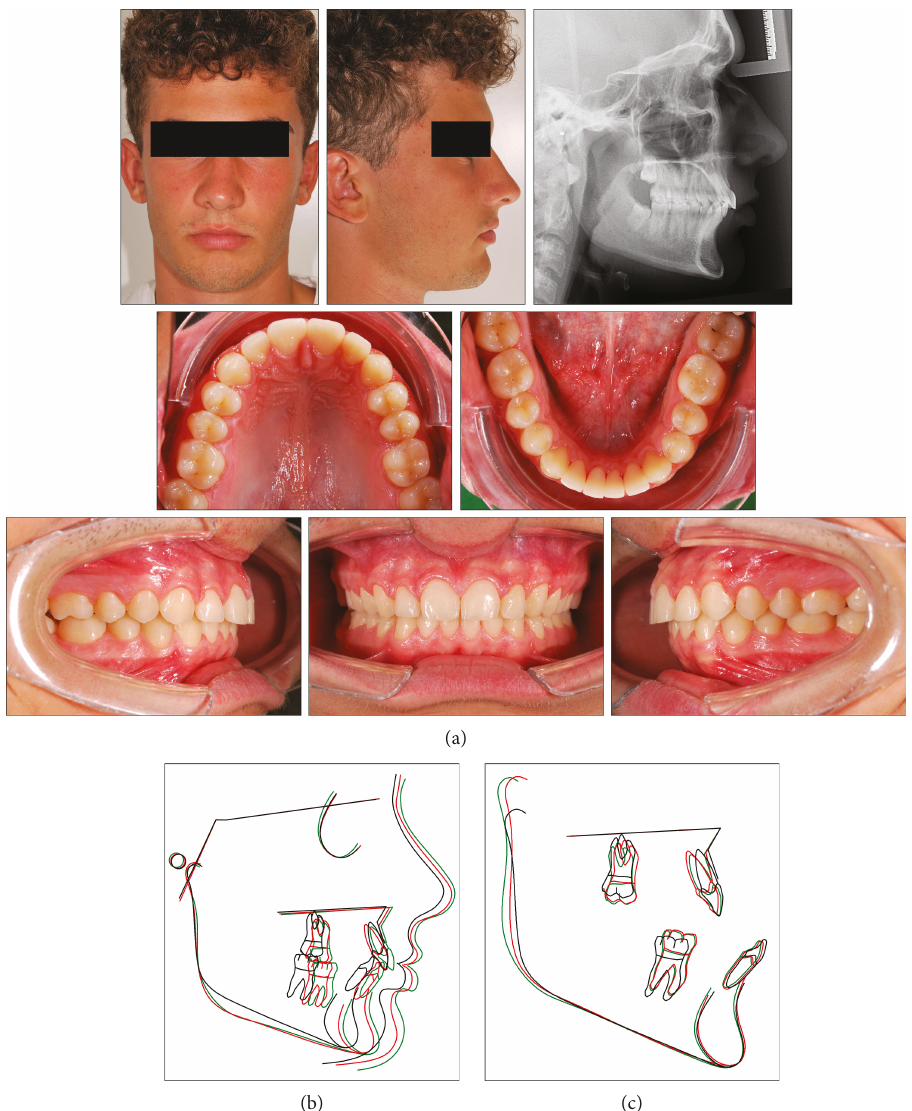
Figure 13: Case 3. (a) Patient after 21 months of follow-up when he was 17 years and 3 months old. (b) Superimposition of pretreatment (black), posttreatment (red), and follow-up (green) cephalometric tracings on stable structures of anterior cranial base. (c) Regional superimposition of cephalometric tracings on the maxilla and